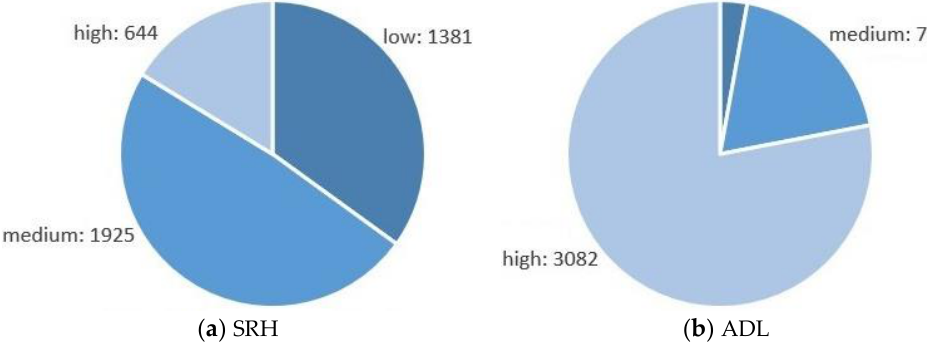
Figure 2. Health distribution of the No. 2 database samples.